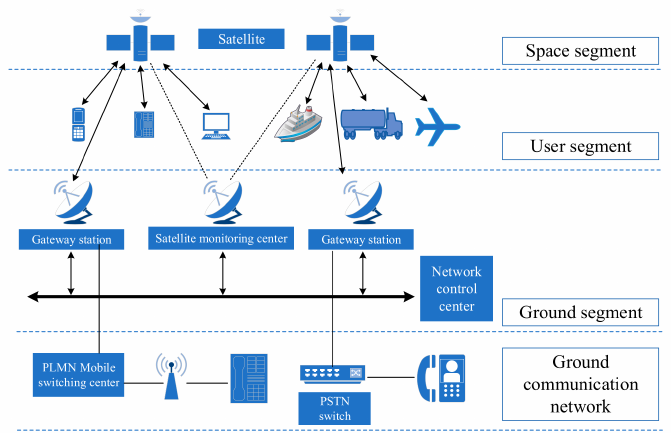
Figure 1. Satellite network communication system (PLMN: public land mobile network, PSTN: public switched telephone